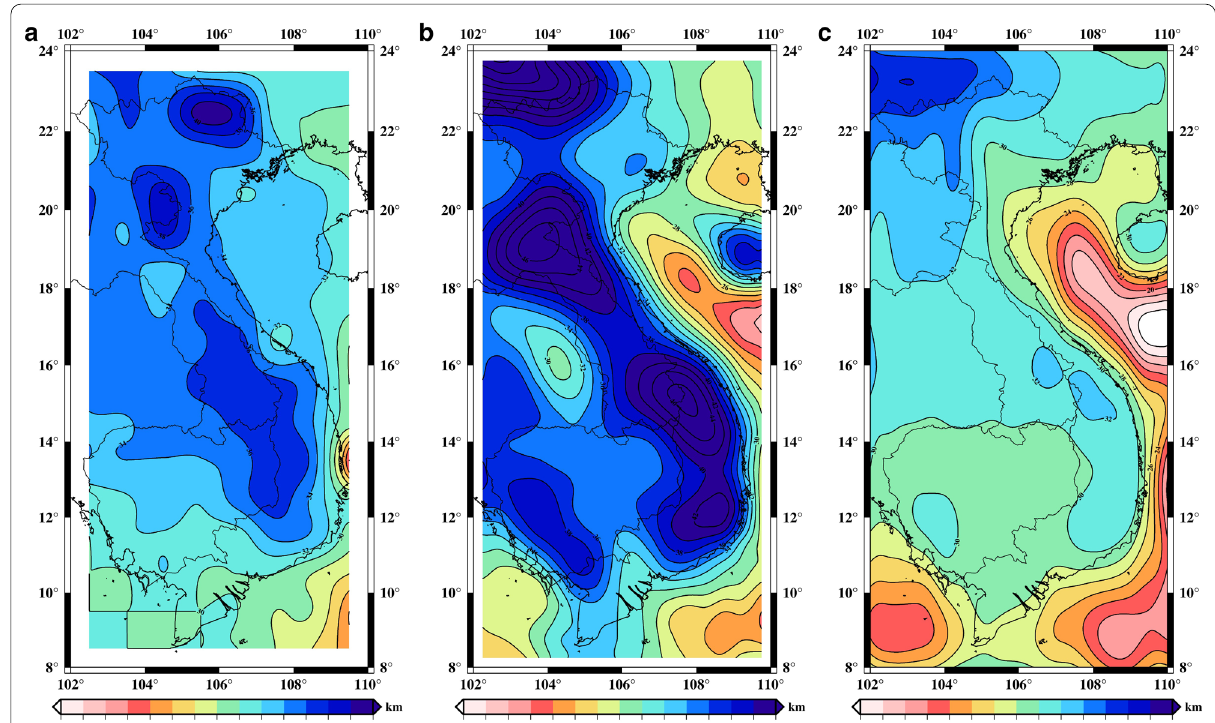
Fig. 10 Comparison of Moho depth models for Vietnam: a CRUST1.0 global model, b GEMMA global model, and c Moho_GRAVITY model (this